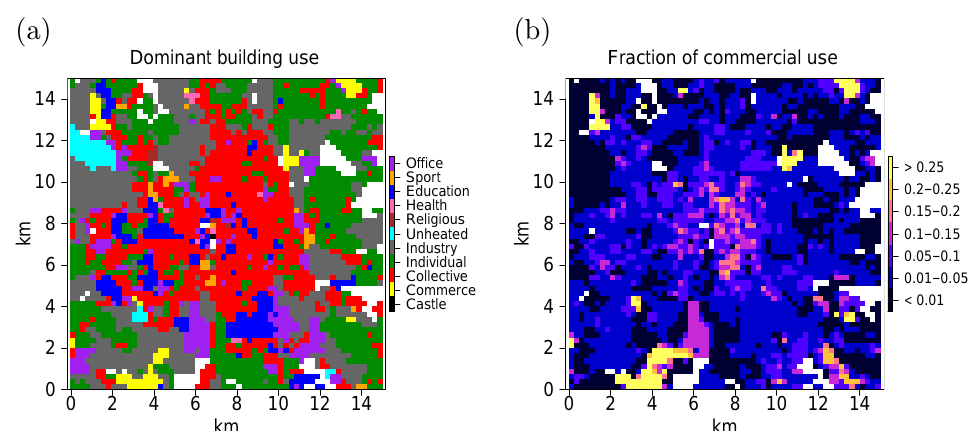
Figure 3. Spatial distribution in the agglomeration of Toulouse, France, of (a) dominant building use at grid point scale and (b) fraction of commercial use. The horizontal resolution is 250m ×